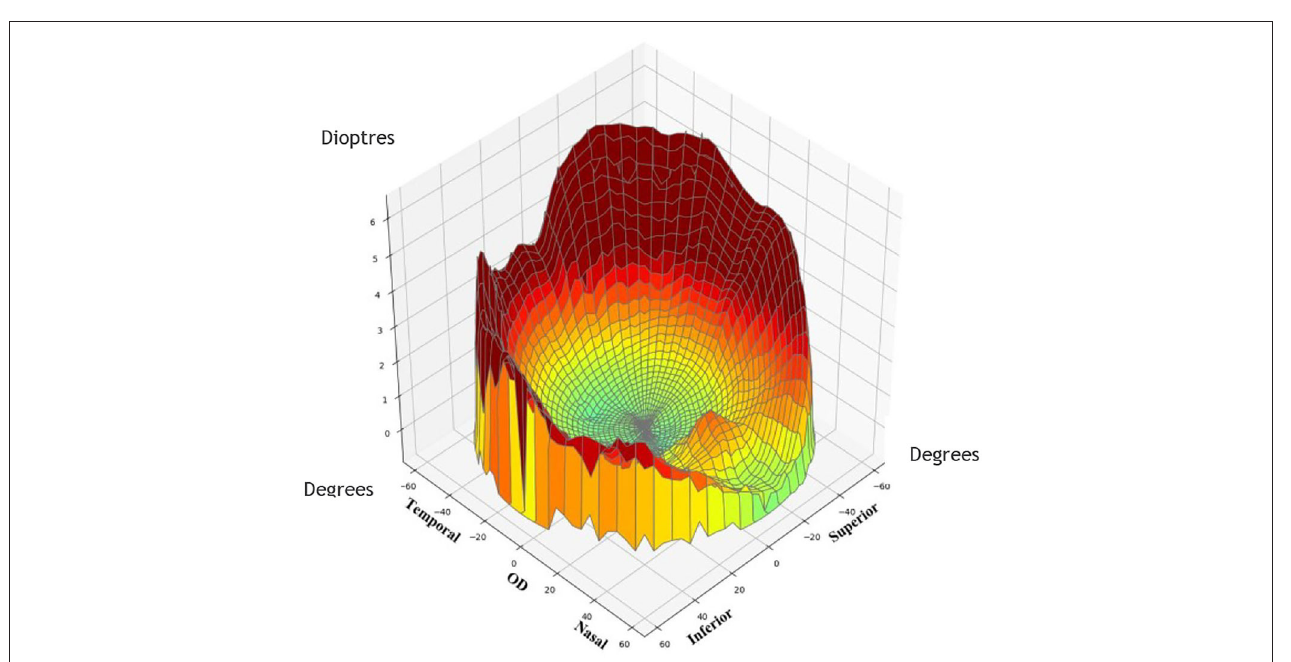
FIGURE 4 | Sketch map of a right eye showing differences between central and peripheric refraction (RDV-S, RDV-I, RDV-T, and RDV-N).